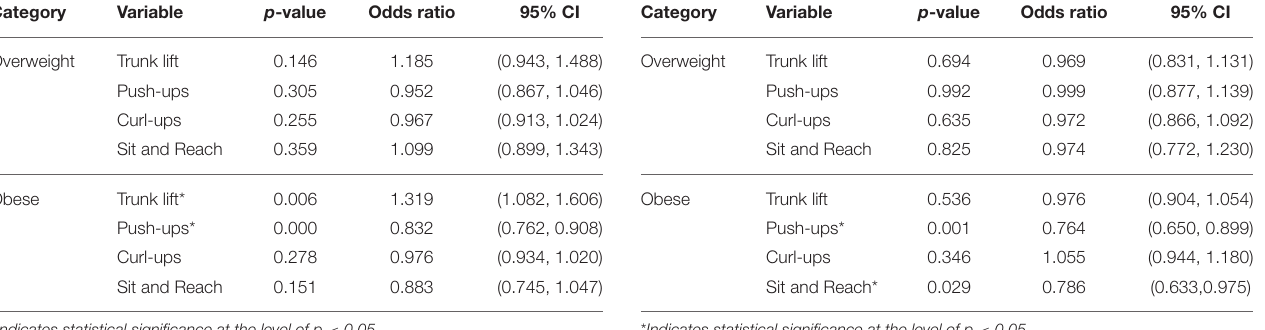
TABLE 8B | Associations between musculoskeletal fitness and weight status in third through fifth grades (reference group: obese). Category Variable Overweight